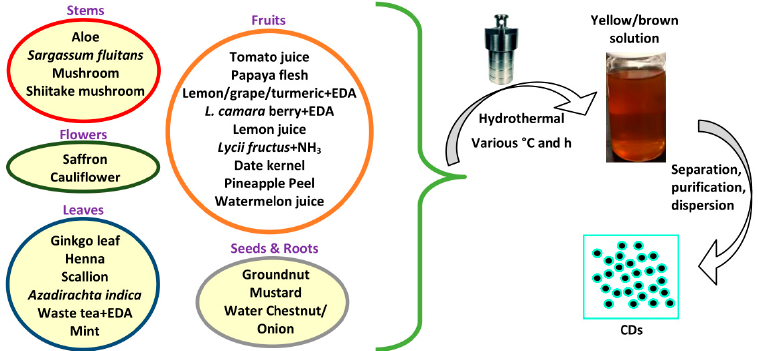
Figure 2. A synthetic procedure scheme for plant part-derived CDs by the hydrothermal treatment